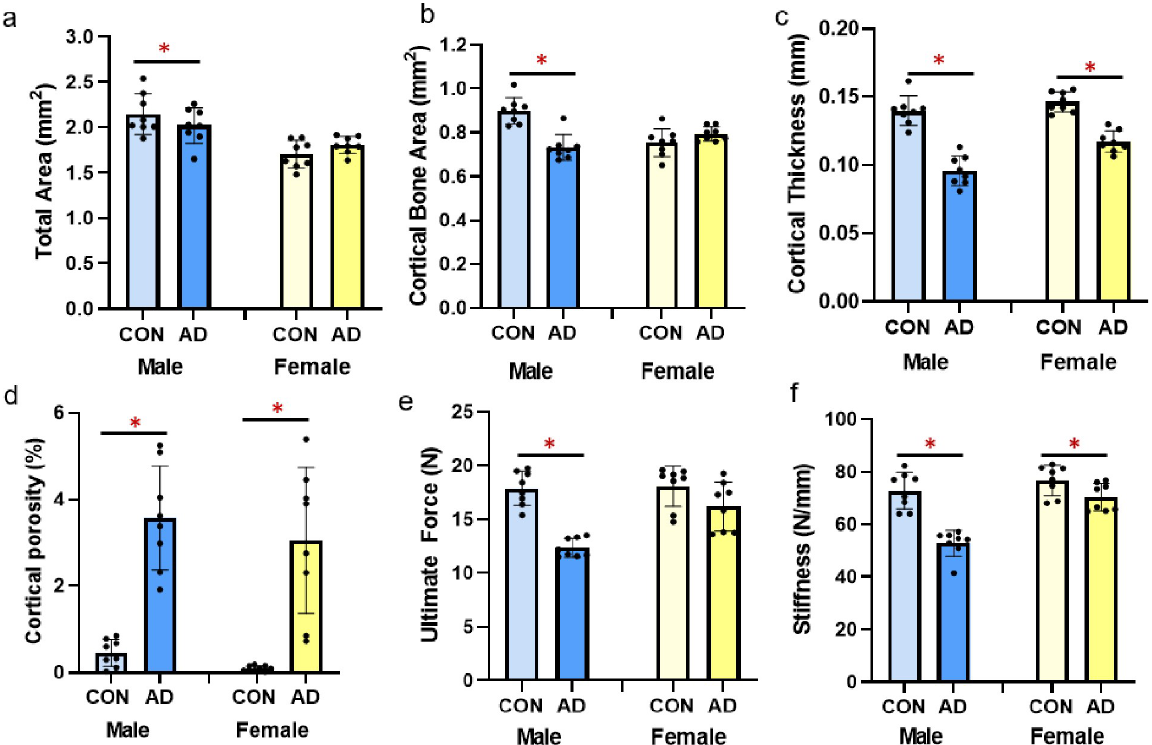
Fig 3. Cortical bone parameters and mechanical properties from the femur of male and female control and adenine mice. A) Total area of the distal 1/3 femur was lower in male adenine mice, but not different in female mice. B) Cortical bone area was lower in male adenine mice with no differences in control vs. adenine in female mice. C) Cortical thickness was significantly lower in both male and female adenine mice. D) Cortical porosity was elevated in both sexes of adenine mice. E) Ultimate force was lower in male adenine mice vs. controls, but not statistically different in female mice. F) Stiffness was lower in adenine mice of both sexes compared to sex-matched controls. Error bars = standard deviation. � Indicates statistical difference (p < 0.05) from t-test between control and adenine within each sex.